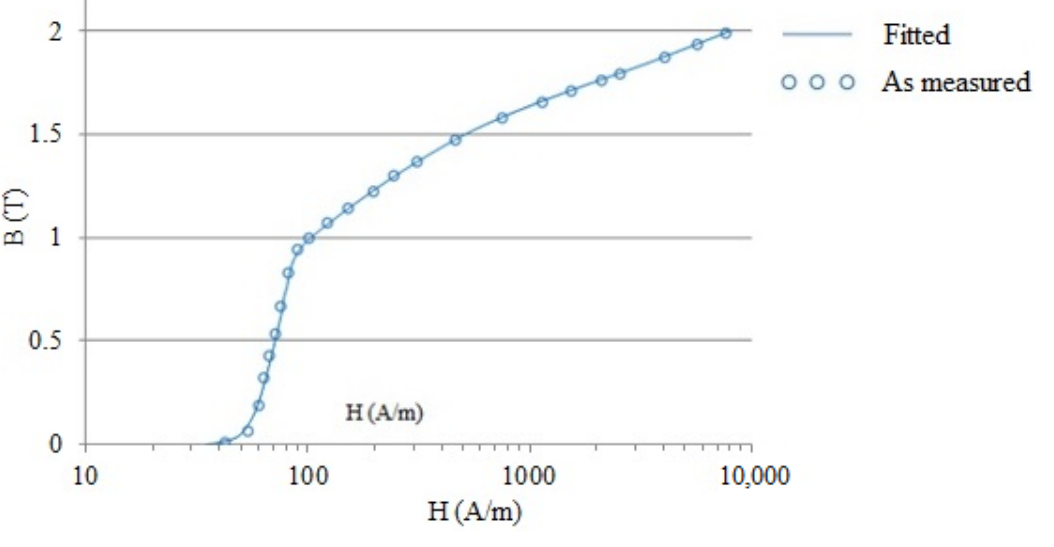
Figure 1. Initial magnetization curve for the pure iron.